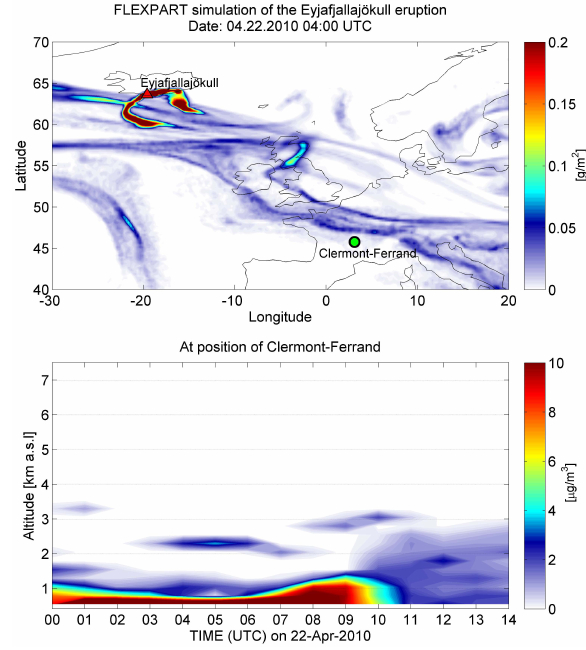
Fig. 7. FLEXPART simulated ash cloud. Total ash column load on 18 April 23:00UTC (upper panel), and simulated vertical distribu- tion of ash over Clermont-Ferrand for 18–19 April (lower panel).